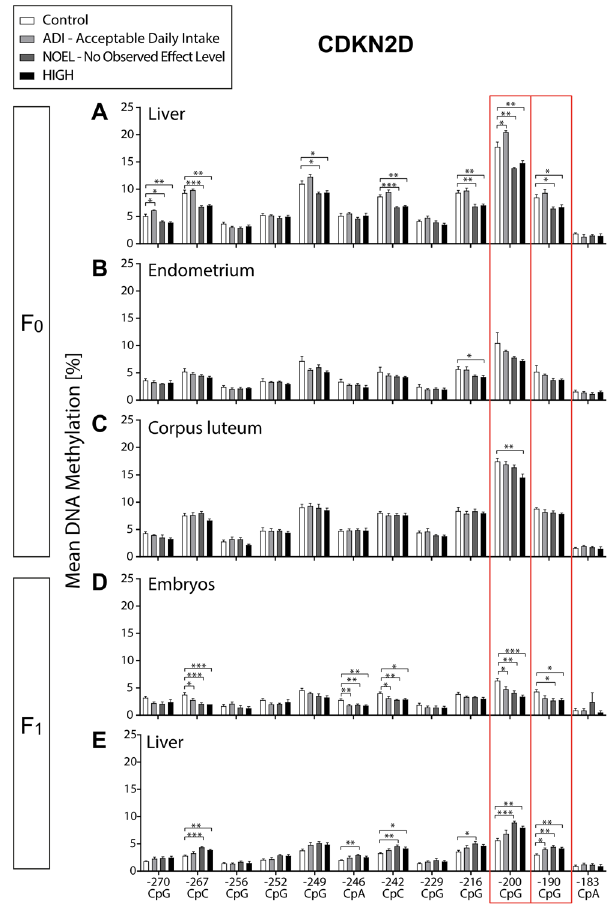
Figure 4. E2 induced subtle, but consistent DNA hypomethylation in the CDKN2D putative promoter region in F 0 liver, endometrium, and corpus luteum, and F 1 embryos, but hypermethylation in liver of F 1 adult gilts. Bar charts represent mean ± SEM of % DNA methylation per group in different shades of grey (0.05, 10, and 1000 μ g/kg body weight/day represented by ADI, NOEL, and HIGH dose, respectively). * , ** , and *** indicate statistical significance with respect to the control group at p < 0.05, p < 0.01, and p < 0.001, respectively (n = 4–6 per group for tissue samples, and n = 8–10 for embryos). ( A ) F 0 liver DNA hypomethylation at CpN − 270, − 267, − 249, − 242, − 216, − 200, and − 190. ( B ) F − 216. 0 endometrium DNA hypomethylation at CpG ( C ) F 0 corpus luteum DNA hypomethylation at CpG − 200. ( D ) F 1 embryo DNA hypomethylation at CpN − 267, − 246, − 242, − 200, and − 190 ( E ) F − 267, − 246, − 242, − 216, 1 liver DNA hypermethylation at CpN − 200, and −